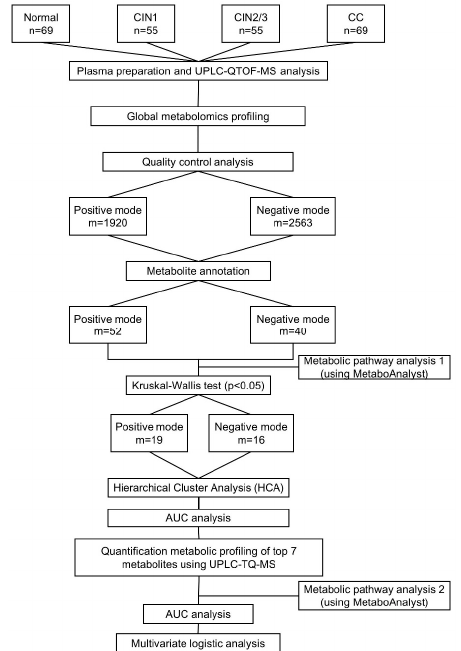
Figure 4. Schematic flow chart of metabolomic analysis in present study. UPLC-QTOF-MS: Ultra-performance liquid chromatography-quadrupole time-of-flight mass spectrometry; UPLC-TQ-MS: Ultra-performance lipid chromatography-triple quadruple mass spectrometry; AUC: Area under the curve; HCA: Hierarchical cluster analysis.